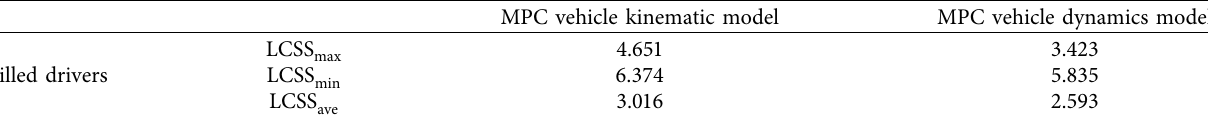
Table 7: Similarities between MPC-based driver models and skilled